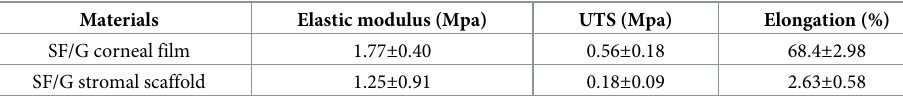
Table 1. Elastic modulus, UTS, and strain at